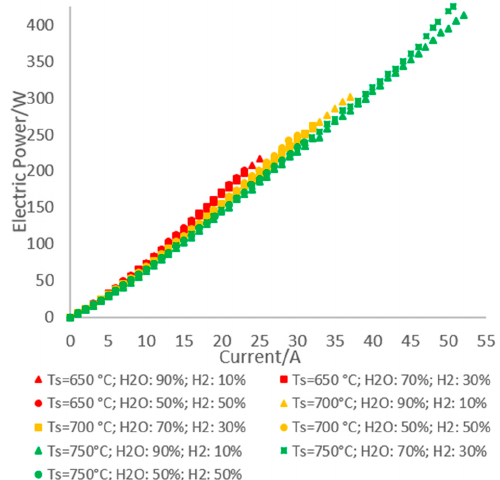
Figure 4. Experimental stack electric power curves in tests from 1 to 9.